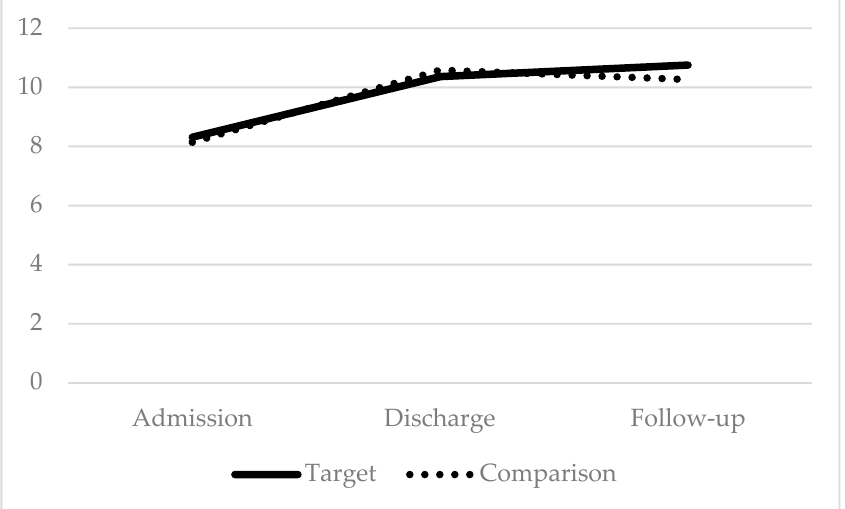
Figure 1. Functional Disability; Lower scores indicate improvement.